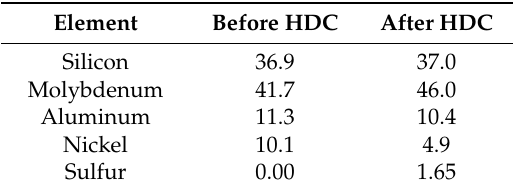
Figure 2. Particle size distribution of raw, control and supported drill cuttings. Table 1. EDX analysis of the concentration (wt.%) of elements on the surface of supported drill cuttings before and after hydrocracking